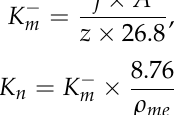
( c ) Figure 4. 3-D surface models of phosphate coatings: ( a ) From a modified solution; ( b ) From a solu- tion with the addition of zinc nitrate; ( c ) From a solution with the addition of calcium nitrate. 3.2. Corrosion Diagrams Obtained by the Contact Corrosion Method To calculate the speed and characteristics of the metal corrosion process, corrosion diagrams (Figures 5–8) are constructed graphically: φ a – i a —the curve of anodic polariza- tion of the anode areas of the metal surface and φ k – i k —the curve of cathodic polarization of the cathodic areas of the metal surface. The analysis of the constructed corrosion dia- grams consists of determining the controlling process, i.e., the stage of the process of elec- trochemical corrosion of the metal, which has the greatest resistance compared to other stages.